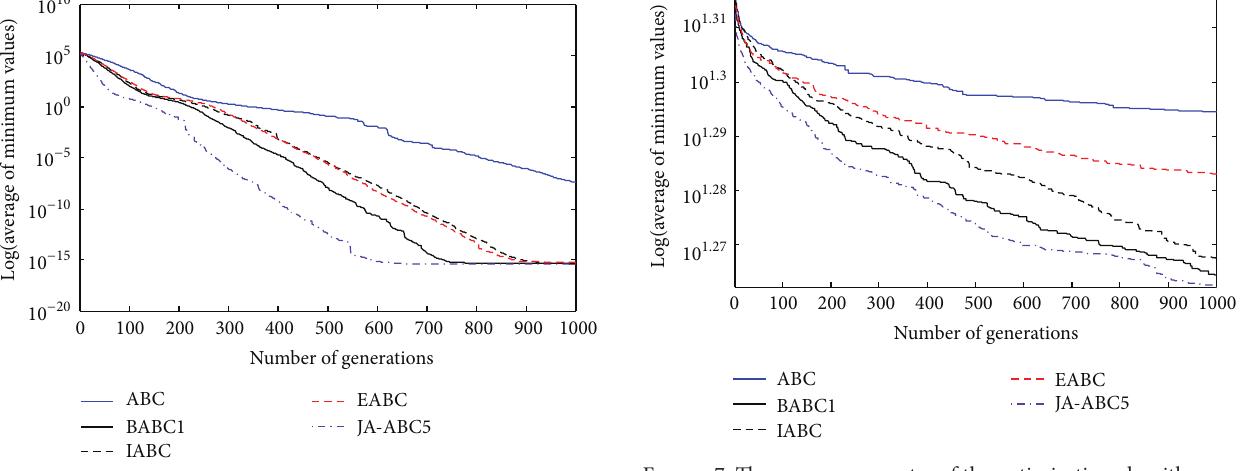
Figure 7: The convergence rates of the optimization algorithms on Rotated Ackley